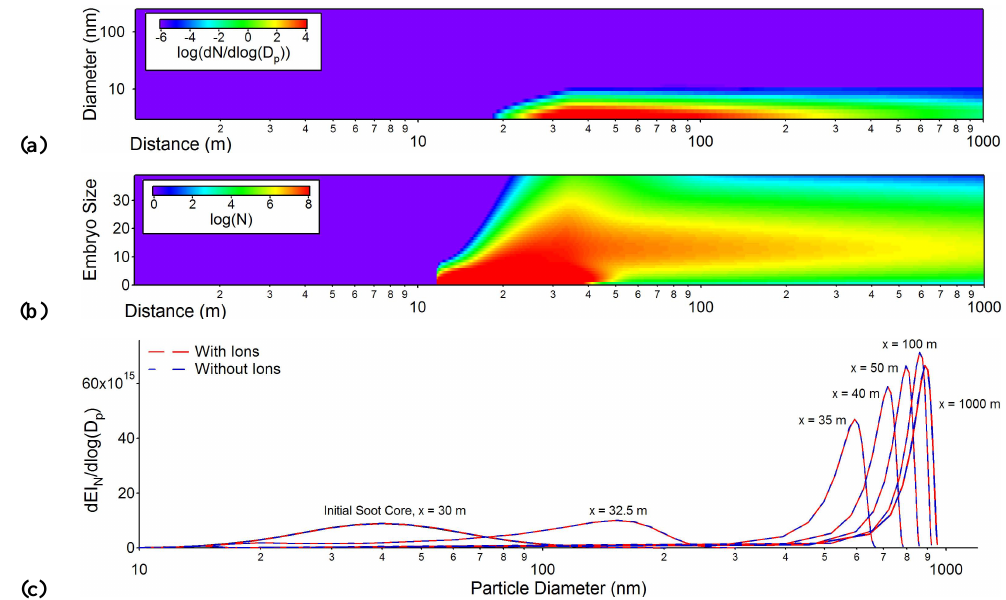
Fig. 4. Simulation results for ion-mediated homogeneous H 2 SO 4 -H 2 O nucleation under the same condition as Fig. 1: (a) concentration and size evolution of volatile H 2 SO 4 -H 2 O droplets; (b) concentration and size evolution of volatile H 2 SO 4 -H 2 O embryos smaller than 40 acid molecules; (c) ice coated soot particle size distributions as a function of downstream distance with or without ion-mediated